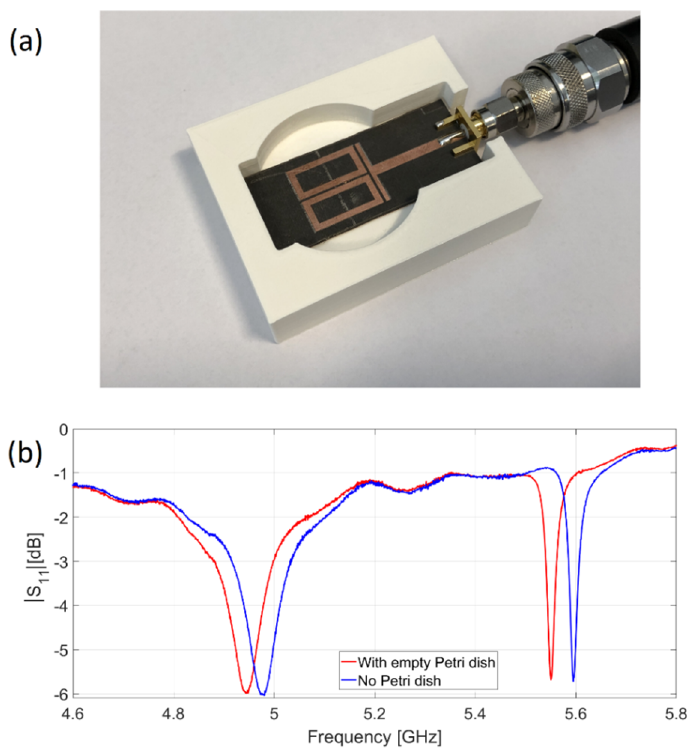
Figure 5. ( a ) Experimental setup. ( b ) Modulus of the measured scattering parameter | S 11 | of the sensor with no Petri dish (blue line) and an empty Petri dish, placed in the optimum position by means of the plastic PLA support (red line).